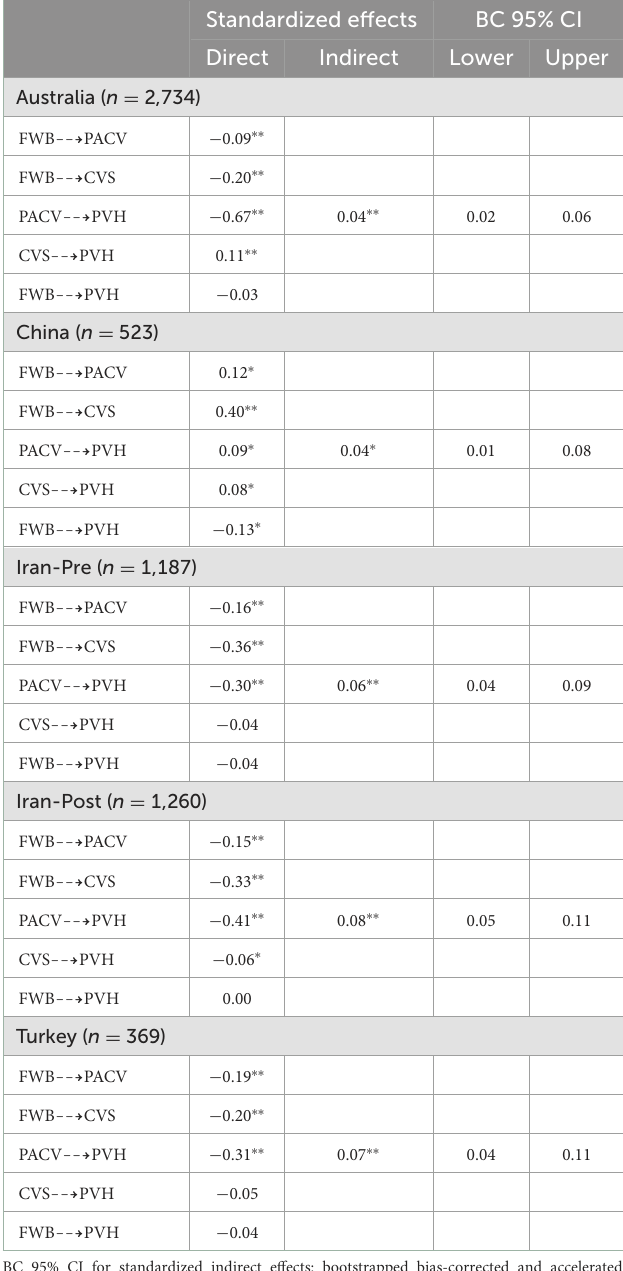
TABLE 6 Model paths indicating the direct and indirect associations between the variables of the study. Standardized